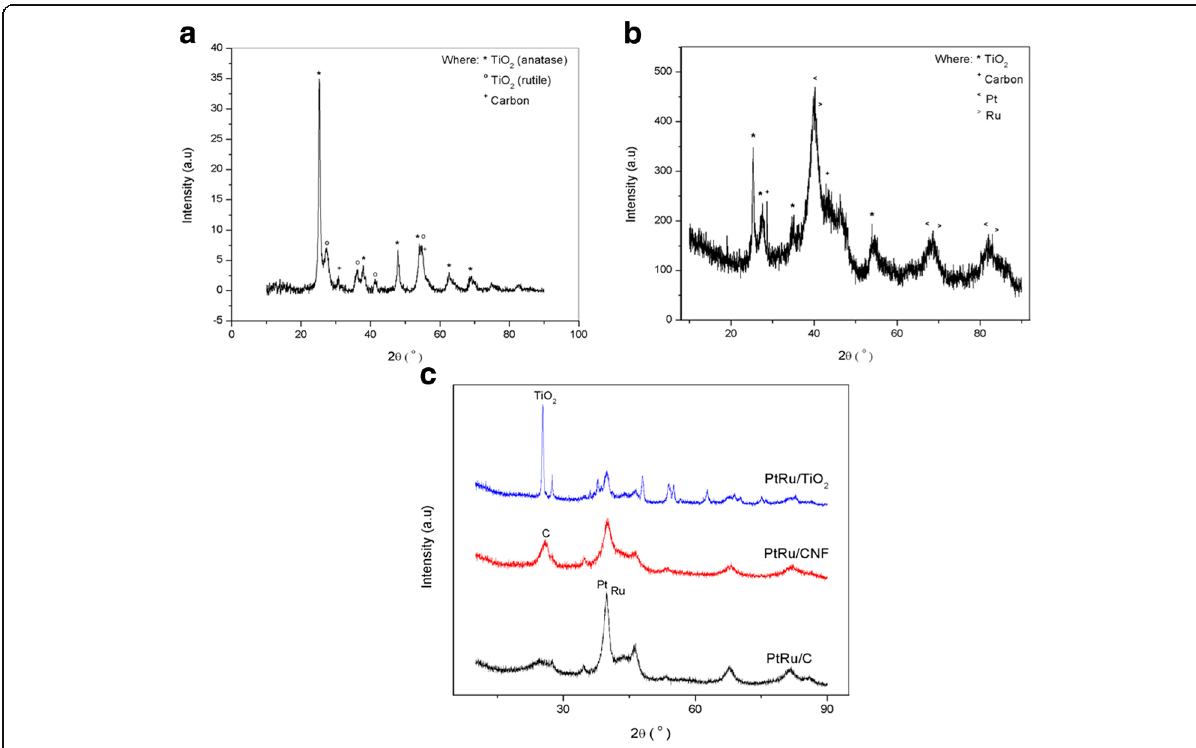
Fig. 1 X-ray diffraction patterns. a TiO 2 -CNF, b PtRu/TiO 2 -CNF, and c compared electrocatalysts